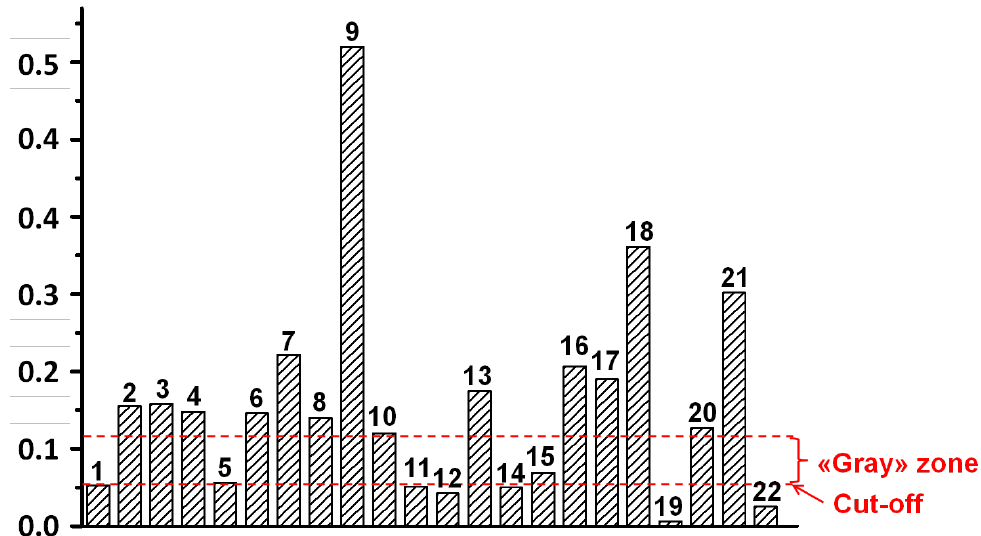
Figure 4. Results of ELISA serodiagnostic of serum from patients with human pulmonary sera dilution: 100 tuberculosis; sera dilution: 100 times.